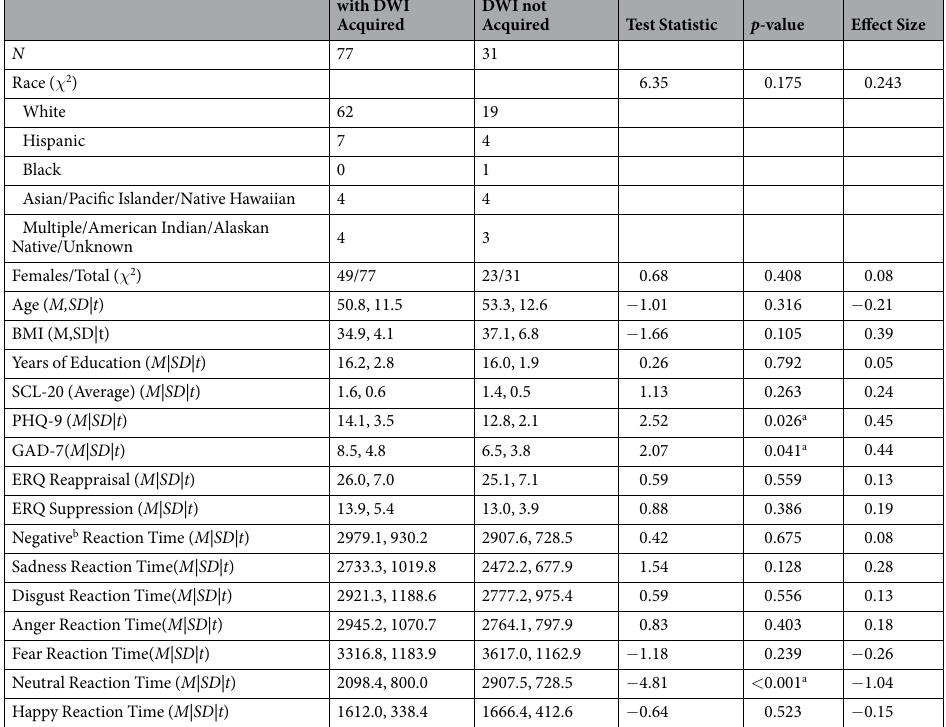
Table 1. Demographic information. DWI = diffusion-weighted imaging; M = mean; SD = standard deviation; t = independent samples t -test t -statistic; χ 2 = χ 2 test statistic; PHQ-9 = Patient Health Questionnaire-9; GAD-7 = Generalized Anxiety Disorder-7; ERQ = Emotion Regulation Questionnaire; a statistically significant; b computed from average reaction time to sadness, disgust, fear, and anger faces. Years of education, PHQ-9 and ERQ Reappraisal scores, and negative, sad, and happy reaction times all had inequivalent variances between